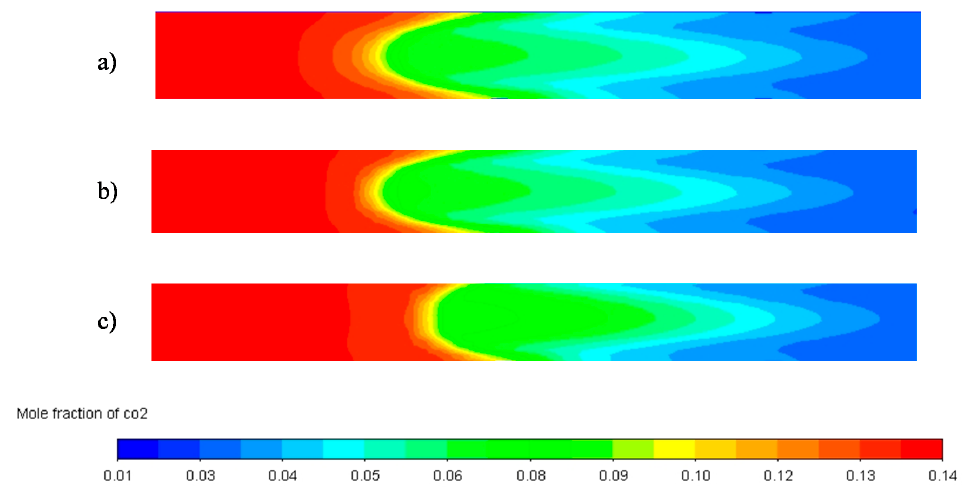
Figure 13. Effect of a 20 K step-drop in the feed gas (523 K to 503 K) on the maximum (Hot Spot) reactor temperature and CH 4 average outlet mole fraction. The disruption begins at t = 0, and a new steady state is established after t ≈ 200 s.